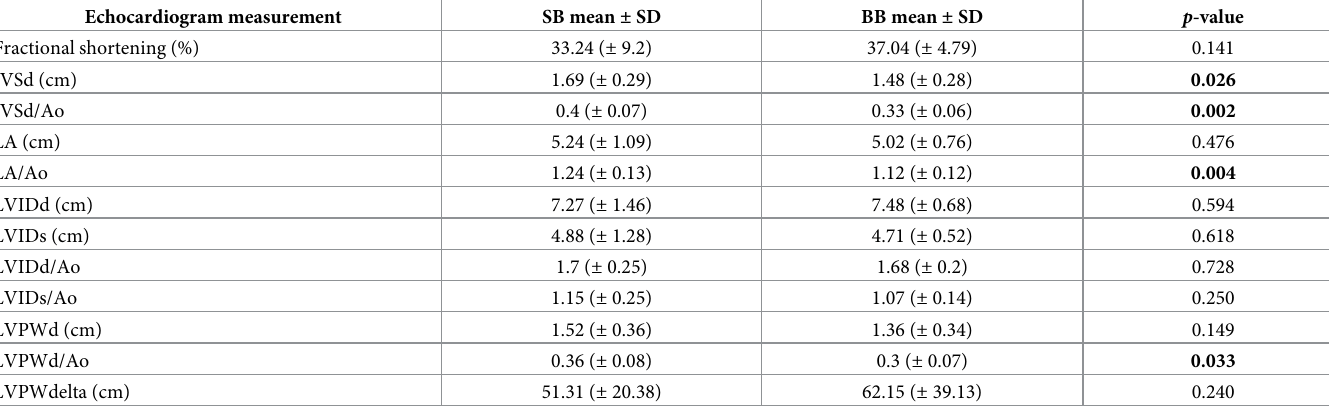
Table 1. Summary of mean two-dimensional echocardiographic measurements of